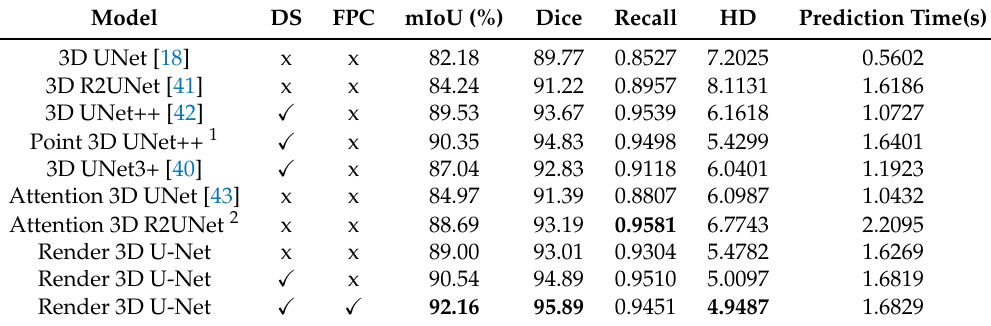
Table 3. Kidney segmentation performance results on the KiTS test dataset.